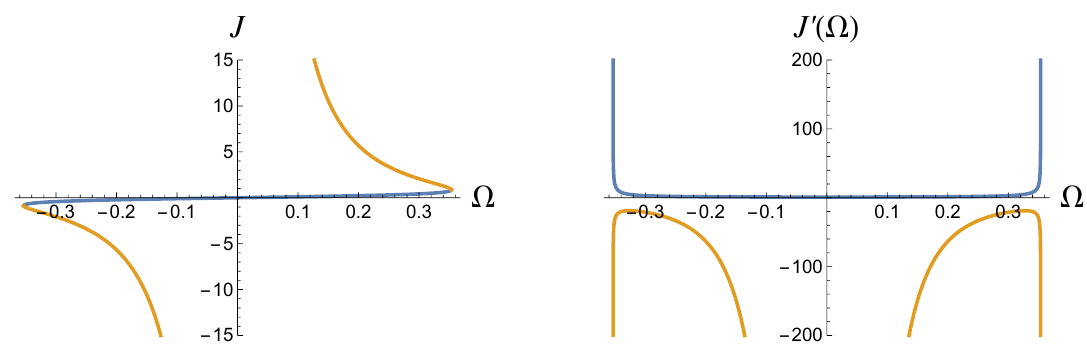
Figure 1 . Left : J ((cid:10)) vs. (cid:10). The blue curve represents the J + ((cid:10)) branch and the orange curve the J (cid:0) ((cid:10)) one. Right : J 0 ((cid:10)) displaying the divergent derivatives at (cid:10) = (cid:6) 1 =